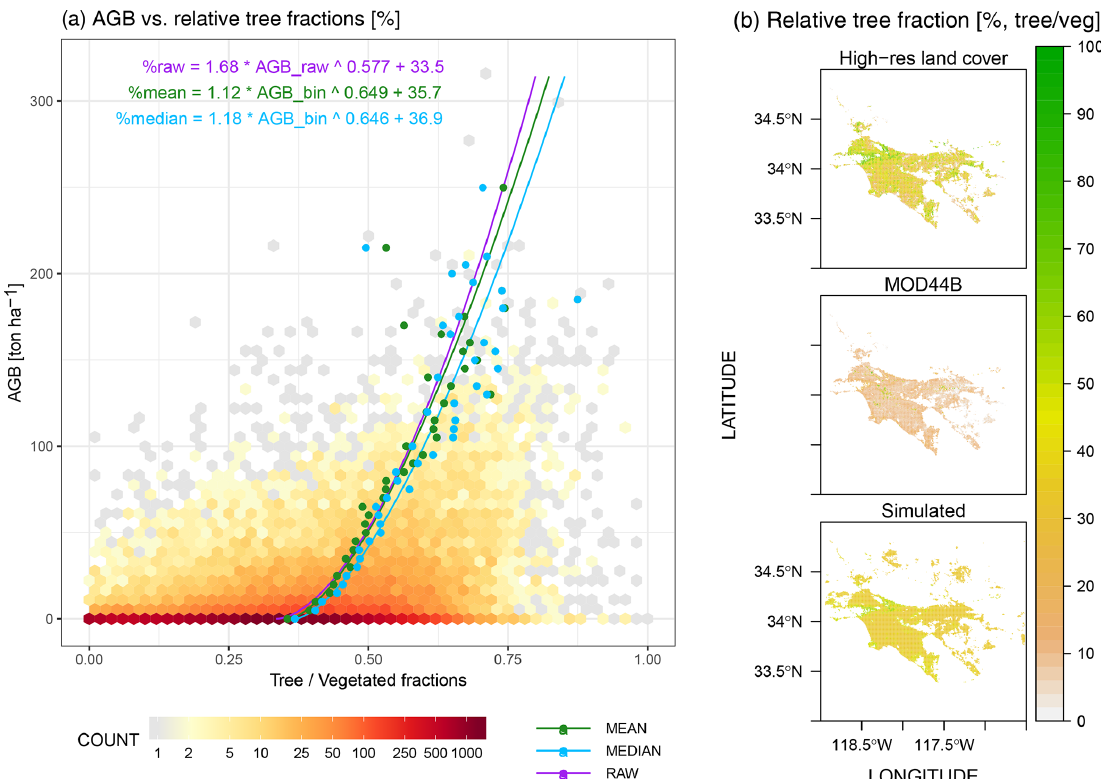
Figure 3. (a) Power-law relationships fitted between the aboveground biomass (AGB) and raw relative tree fractions (purple line) as well as fits using binned AGB and mean or median relative tree fractions per AGB bin (green or blue lines). The statistical fit in purple is chosen to predict relative tree fractions within cities. (b) Spatial distributions of calculated relative tree fractions (%) from a high-resolution NAIP- based land cover classification product (Coleman et al., 2020) (top panel), vegetation continuous fields from the MOD44B v6 product (middle panel), and our approximation (bottom panel) using AGB and the statistical fit illustrated in panel (a)